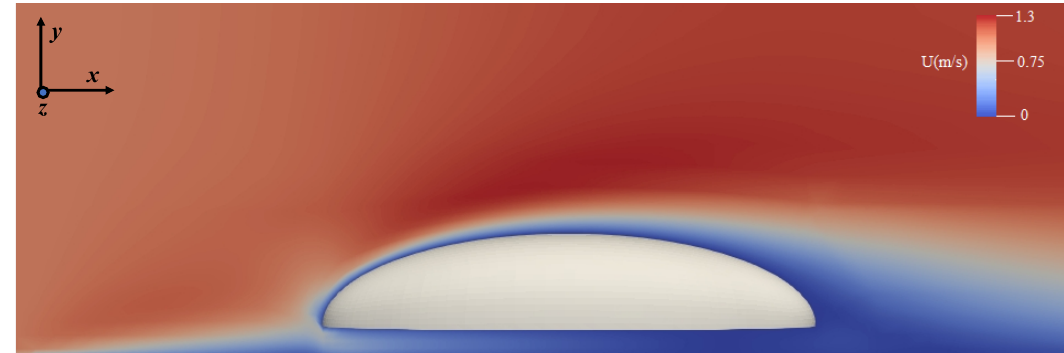
Figure 4. Distribution of the magnitude of fluid velocity around the body in the steady state (converged solution) for the zero incidence angle case, α = 0 deg (run